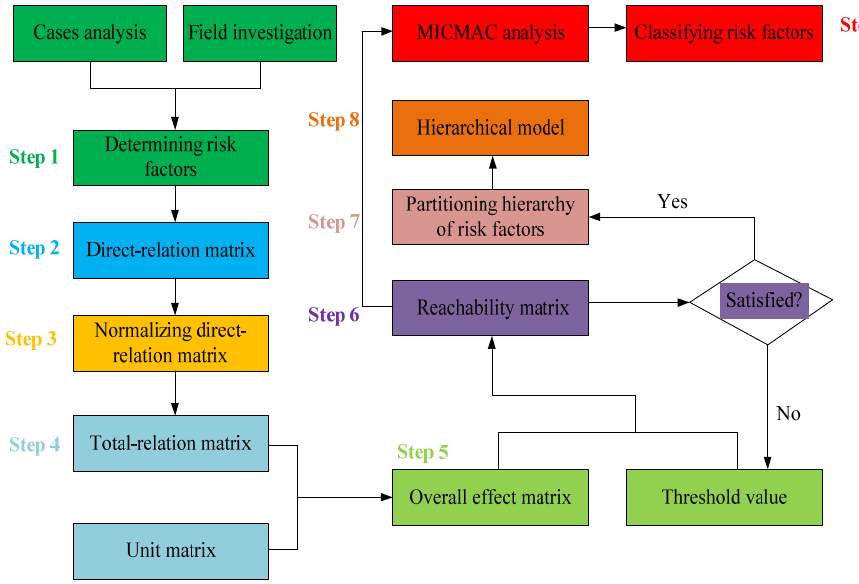
Figure 2. The flowchart of the established hierarchical structure model of gas explosions.